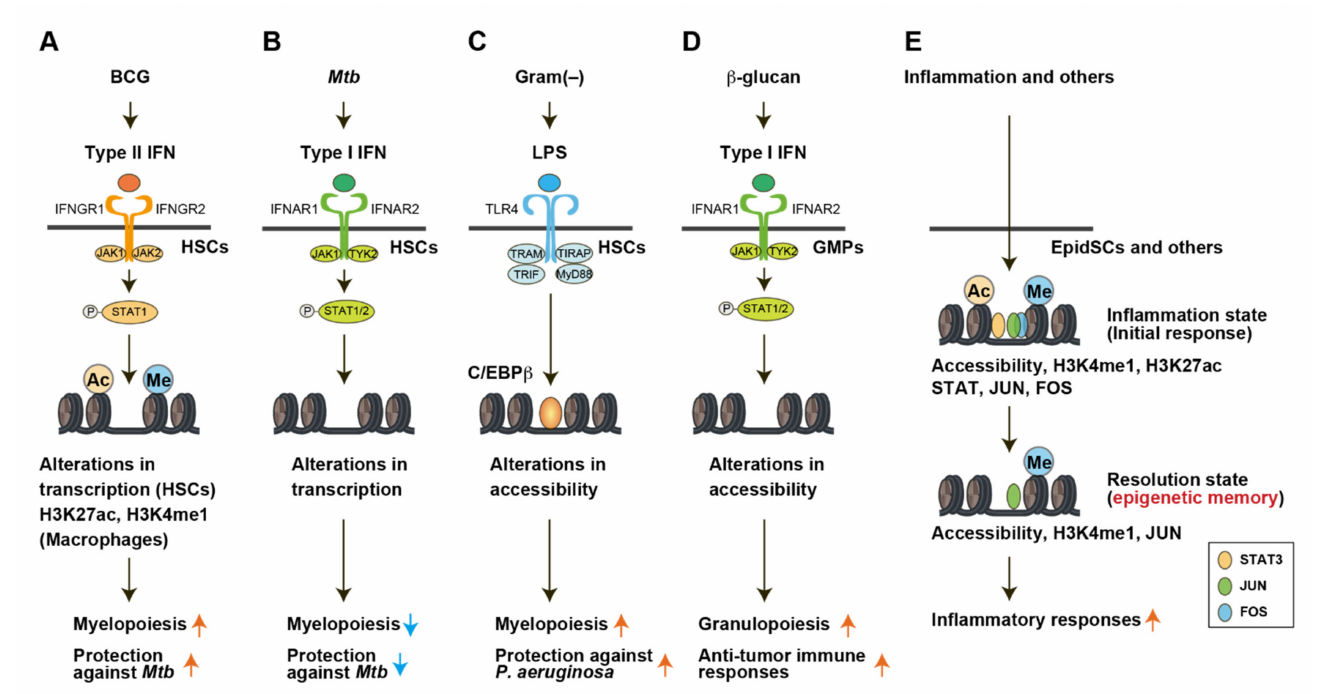
Figure 4. Signaling pathways that induce trained immunity through epigenetic